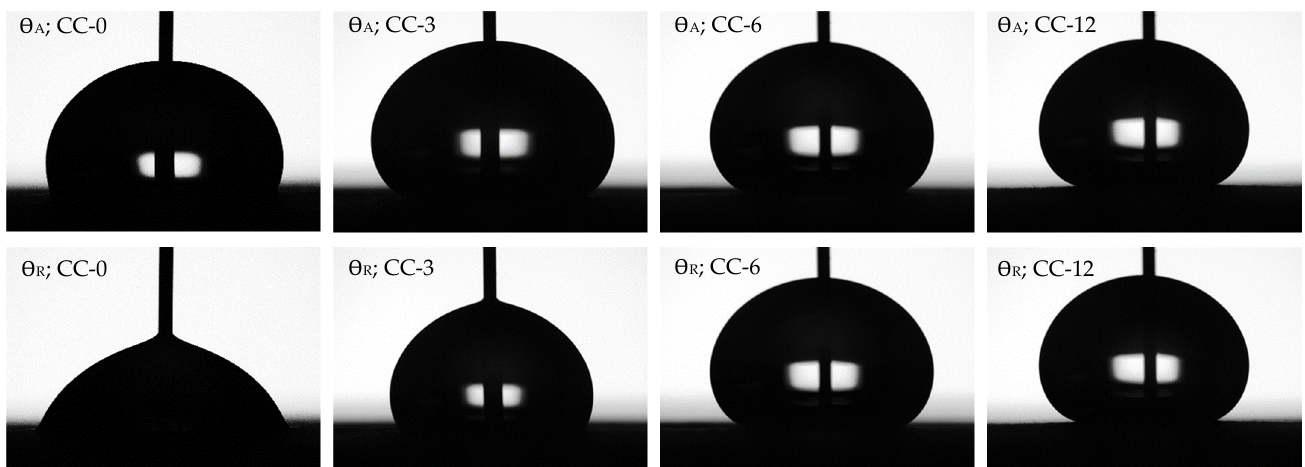
Figure 8. Advancing and receding drops of distilled water as standard liquid on uncoated and HMDSO plasma polymerised coated leather samples.